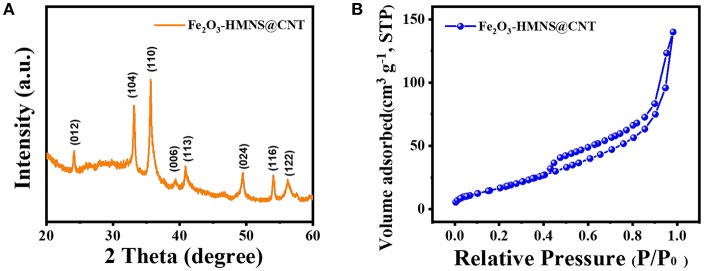
(A) XRD patterns, (B) N2 adsorption–desorption isotherms of the Fe2O3-HMNS@CNT composite.